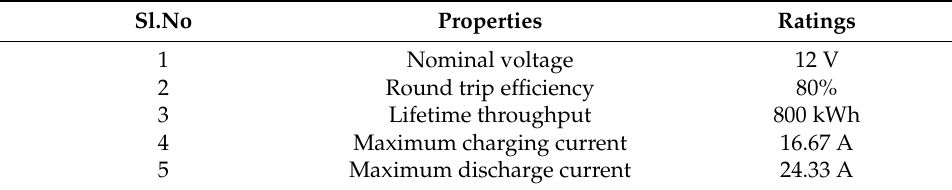
Table 4. Properties of generic 1 kWh lead–acid battery